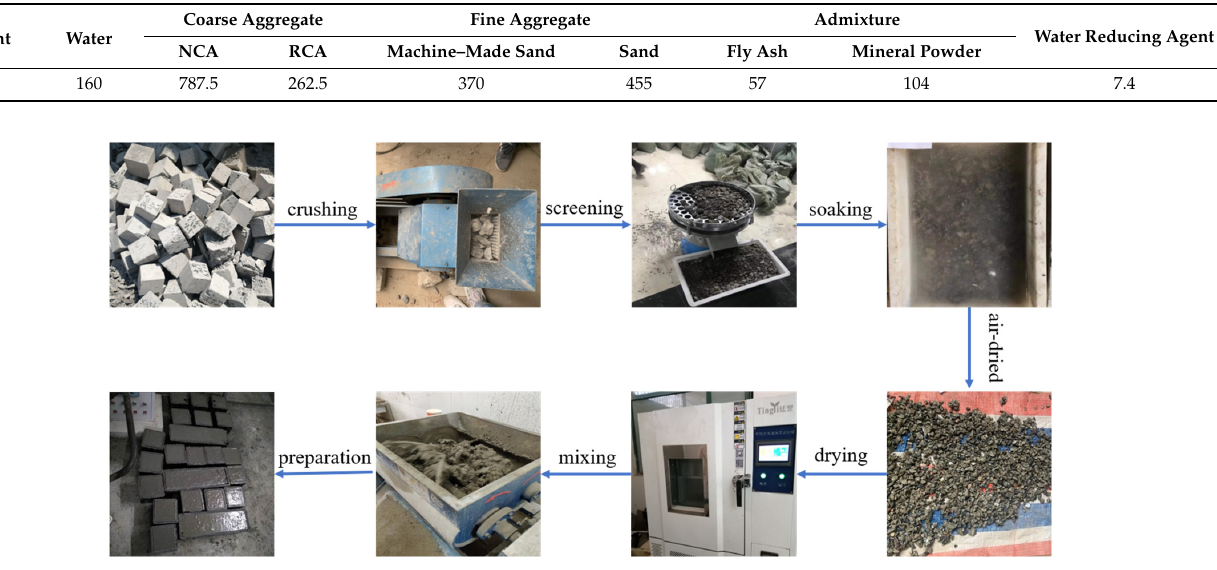
Table 2. Mix ratios of concrete (kg/m 3 ).